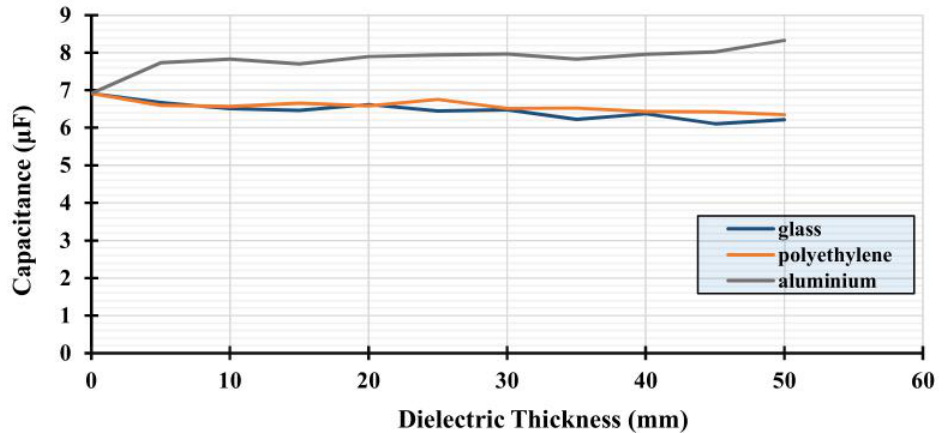
Figure 15. Primary capacitance.